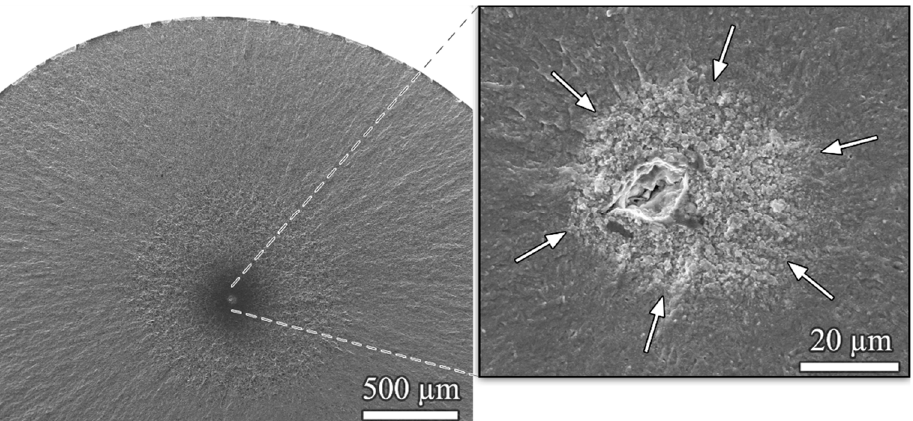
Figure 5. Fatigue crack initiation in 100Cr6 bearing steel at an interior non ‐ metallic inclusion after ultrasonic fatigue testing at σ a = 875 MPa, R = − 1, N f = 2.4 × 10 9 cycles; the border of FGA is marked with arrows.